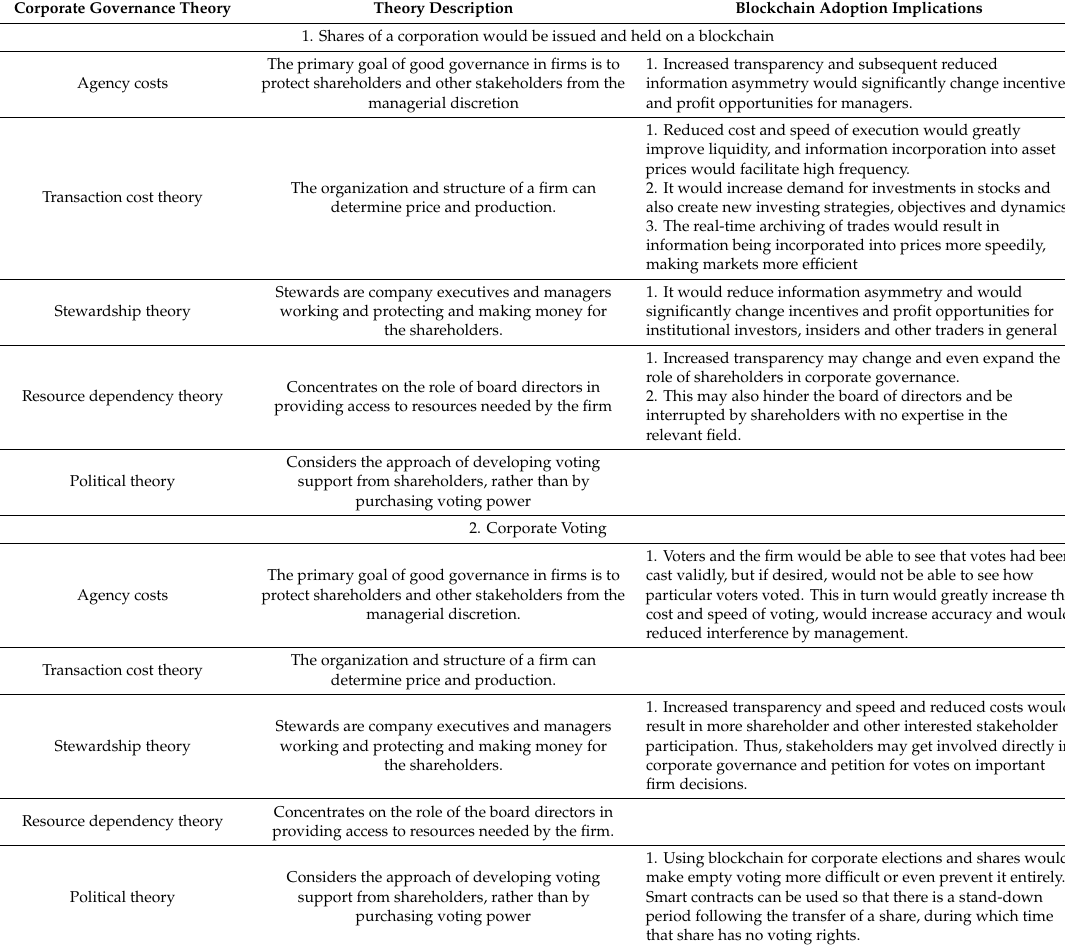
Table 3. Blockchain Adoption Implications and Corporate Governance